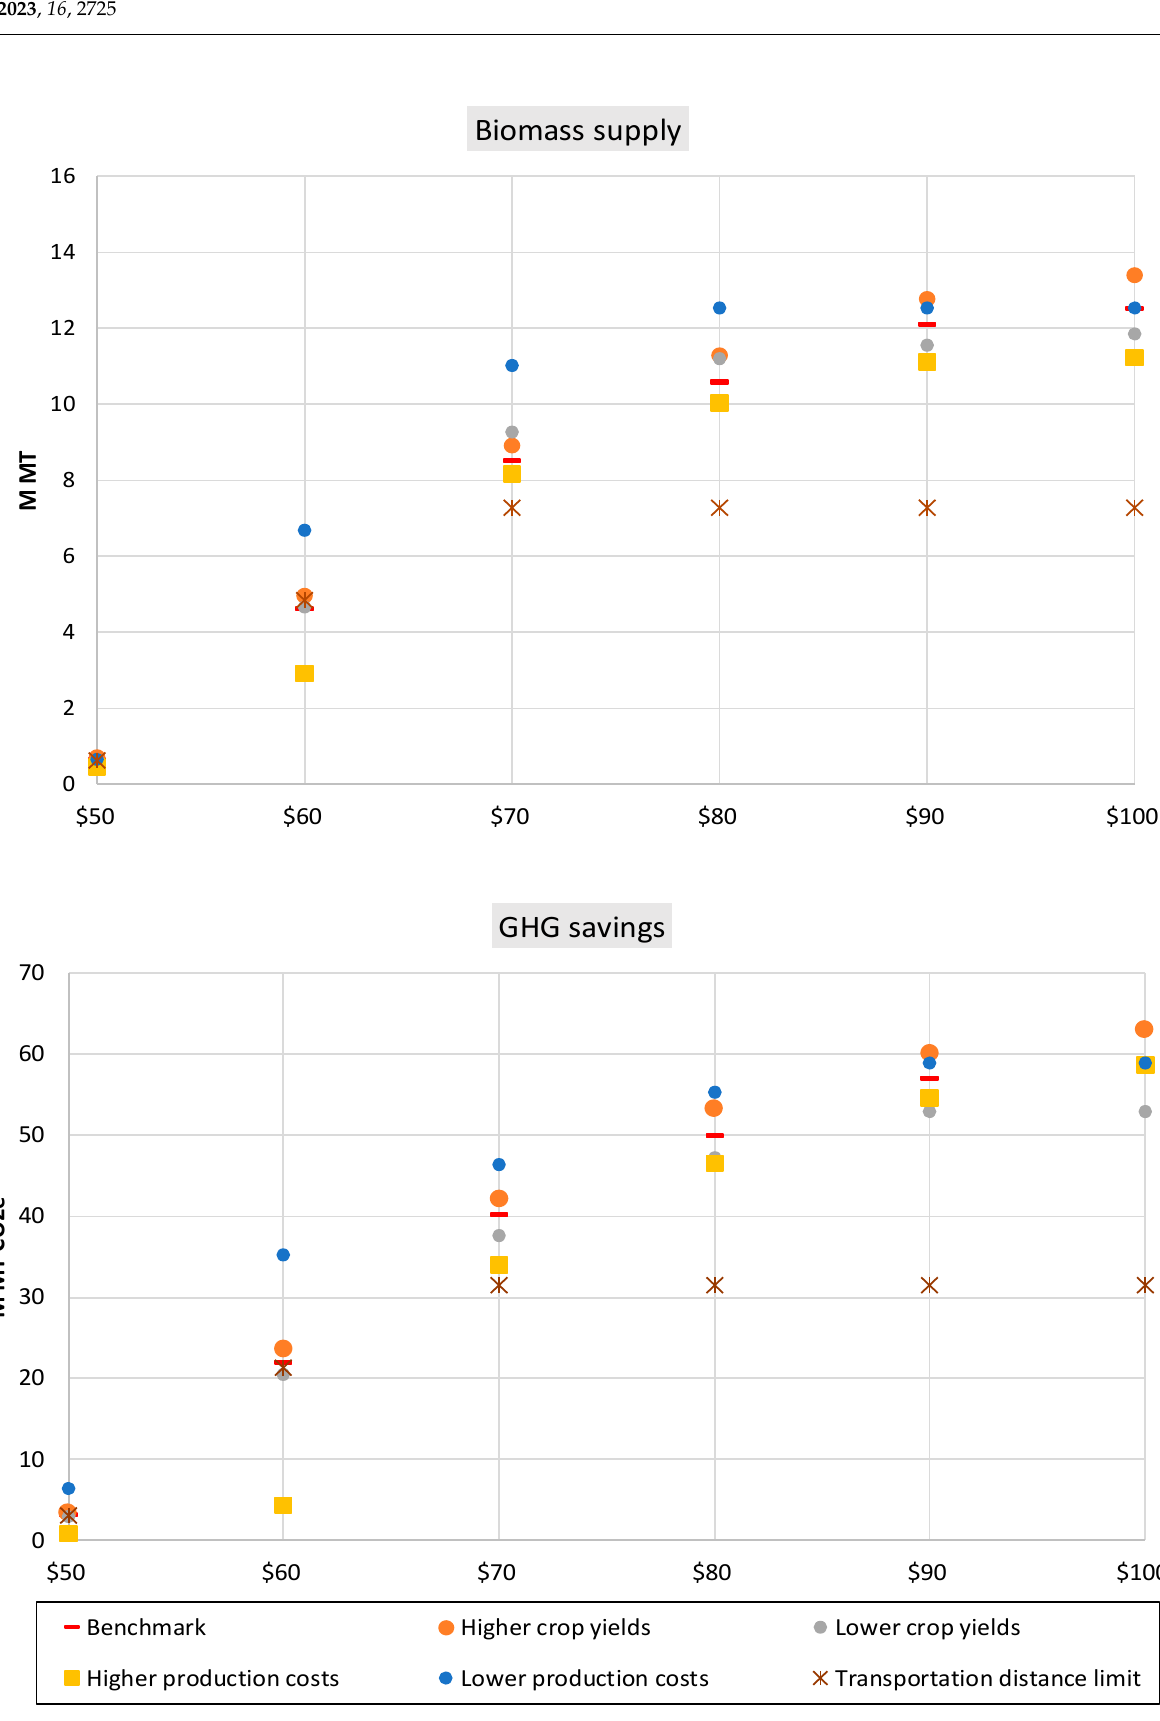
Figure 7. Total biomass supply and net GHG savings for each sensitivity scenario.